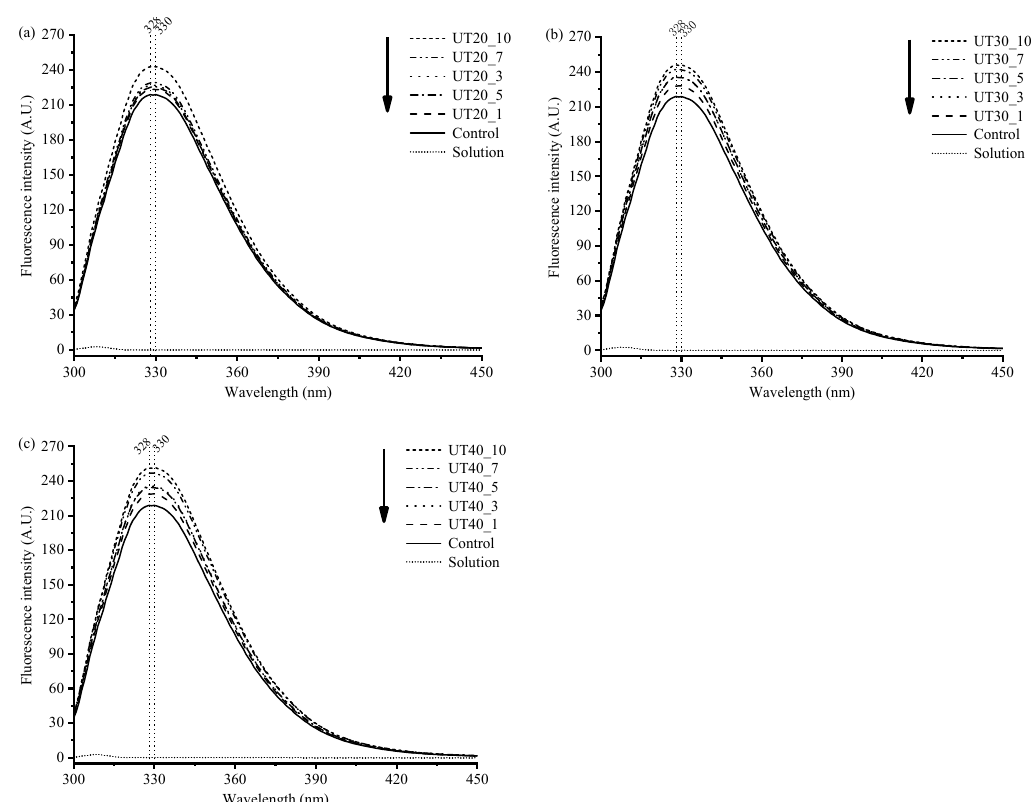
Figure 3. Intrinsic fluorescence spectra of goat milk β -lactoglobulin samples treated at different amplitudes (20% ( a ), 30% ( b ), 40% ( c )) and different treat times (0, 1, 3, 5, 7, 10 min). Phosphate buffer (PB) solution was set as background.